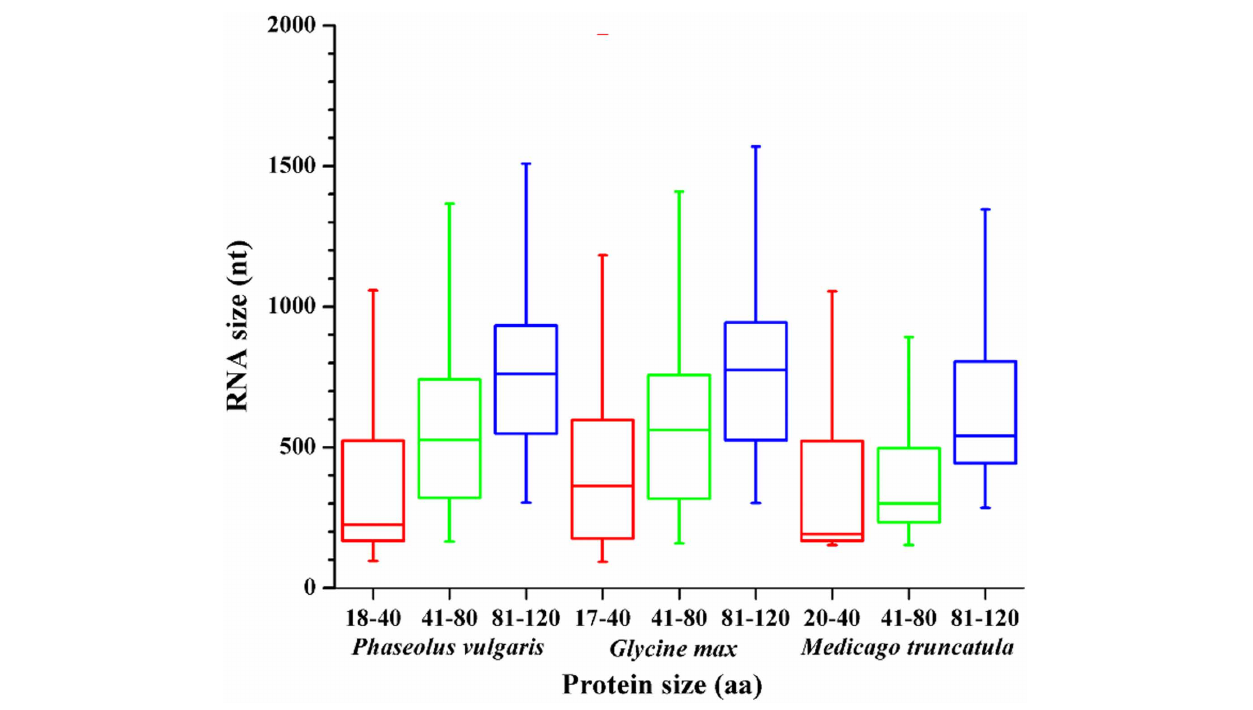
FIGURE 3 | RNA sizes for different ranges of protein size represented in a box and whisker plot. The center lines indicate the medians, the top and bottom of each box indicate the first and third quartiles, and the whiskers extend to the most extreme data points.